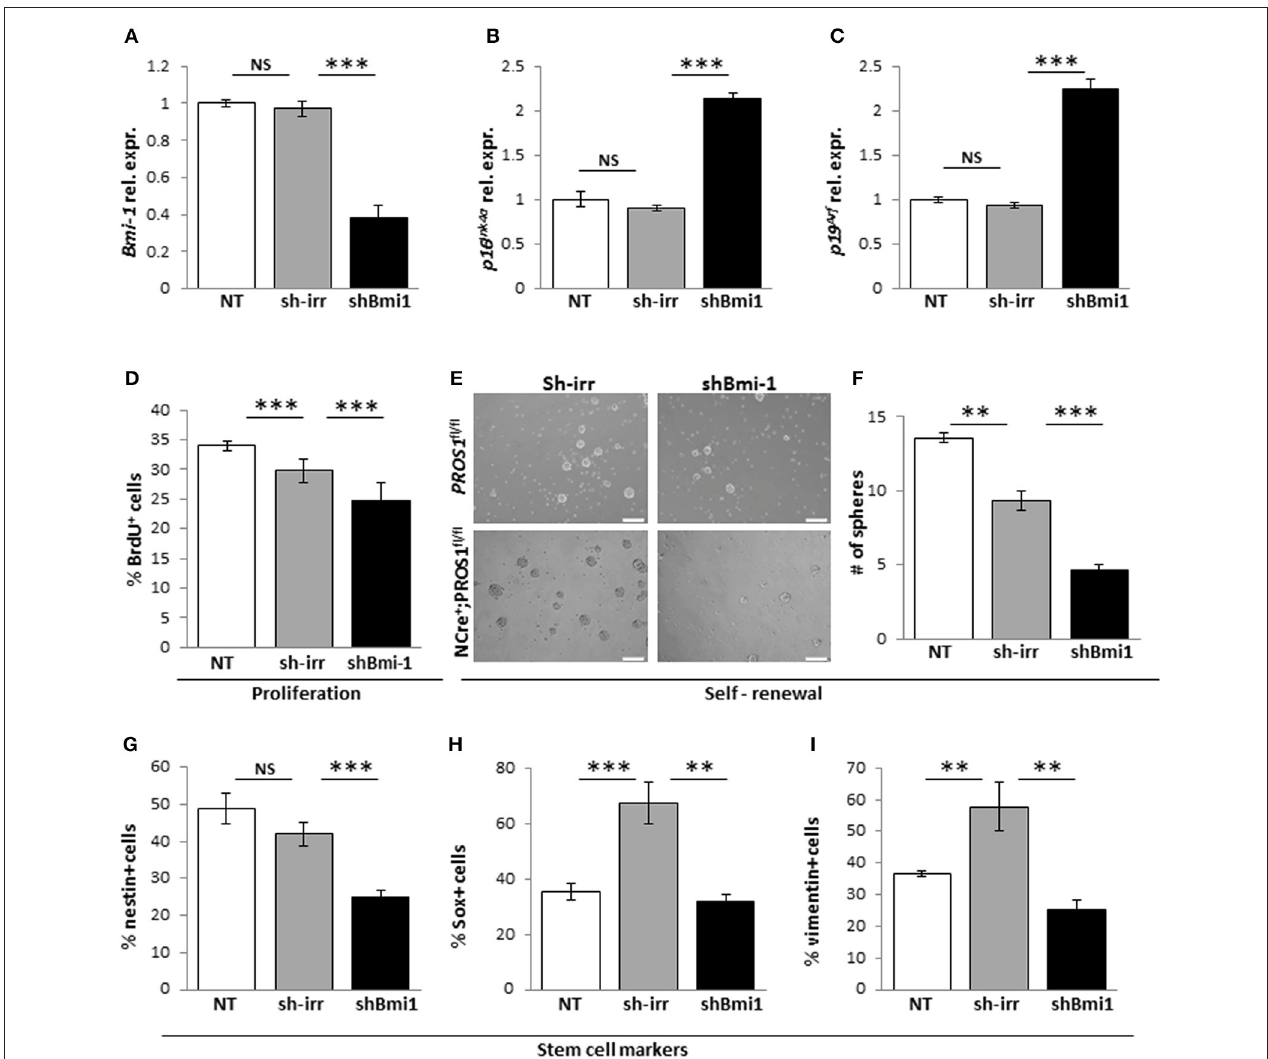
FIGURE 5 | Knockdown of Bmi-1 in Pros1 -cKO NSCs restores Bmi-1 signaling and self-renewal. RT-qPCR relative expression levels of Bmi-1 (A) p16 Ink4a (B) and p19 Arf (C) in neurospheres derived from Pros1 -cKO NSPCs following Bmi-1 knockdown. *** P < 0.001; NS, no statistical significance. Non-treated NSPCs (NT, white bar), or cells electroporated with a control sh vector (sh-irr, gray bar) were not affected. Cells electroporated with sh-Bmi-1 are presented by the black bars. Graphs represent mean values ± from four individual experiments. At least two embryos from each genotype were pooled in each experiment. (D–I) Bmi-1 knockdown in cKO NSPCs suppresses their increased proliferation and self-renewal. Proliferation (D) was measured by BrdU incorporation (10 µ M added to the culture medium 4 h prior to fixation), and self-renewal (E,F) was measured by the number of neurospheres generated from 2,500 NSPCs. Neurospheres were documented by phase-contrast microscopy (E) and quantified (F) . *** P < 0.001. At least 60 neurospheres per genotype were scored for statistical evaluation. Graphs represent mean values ± from four individual experiments. At least two embryos from each genotype were pooled in each experiment. (G–I) Phenotypic rescue of NSCs markers following shBmi-1 in cKO NSPCs. Scoring the percent of nestin + (G) , Sox2 + (H) , and vimentin + (I) cells in non-treated, sh-irr and shBmi-1 treated cells. *** P < 0.001; ** P < 0.01. Graphs represent mean values ± from four independent experiments. At least two embryos from each genotype were pooled in each